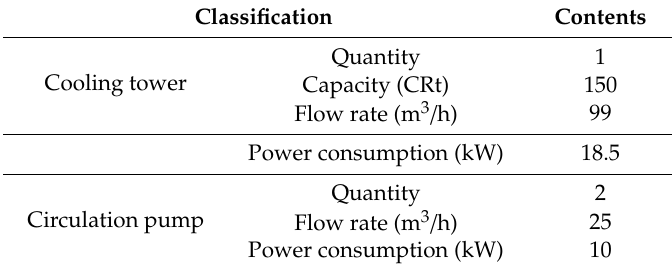
Table 7. Auxiliary heat source system